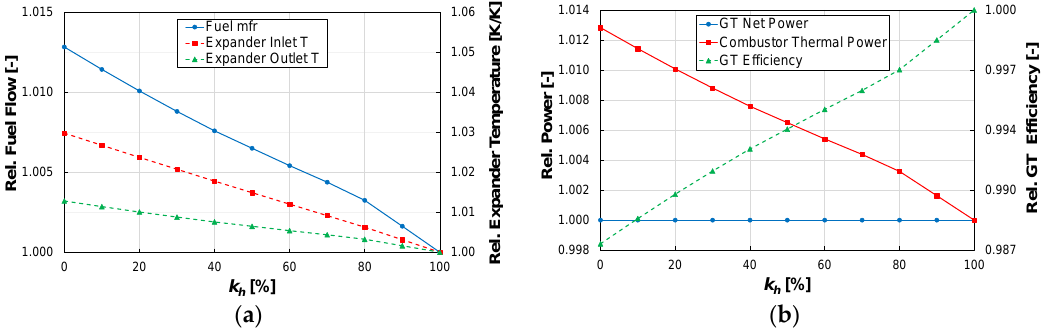
Figure 5. TGSim Plus™ results of a steady state sensitivity analysis varying the value of k h . The results are normalised with respect to the corresponding values at k h = 1. ( a ) Primary axis: normalised fuel gas mass flow rate (solid blue line); Secondary axis: normalised expander inlet and outlet temperatures (dashed red and green lines respectively), ( b ) Primary axis: normalised GT net power and combustion thermal power (solid blue and red lines respectively); Secondary axis: normalised GT efficiency (dashed green line).